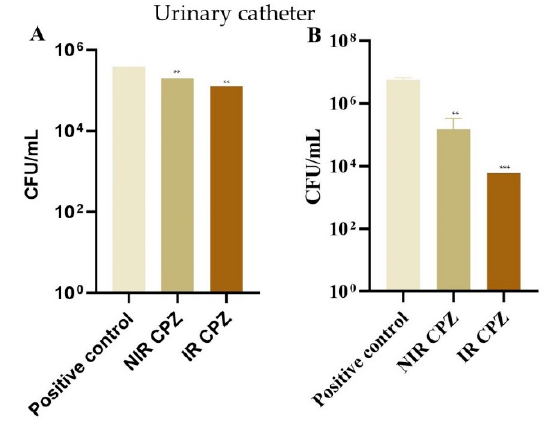
Figure 5. The values of CFU / mL for ( A ). P. aeruginosa clinic, ( B ). MRSA, attached on silicone urinary catheter, all catheter pieces were treated before with non-irradiated and irradiated CPZ solutions. Legend: NIR-CPZ = non-irradiated CPZ and IR-CPZ = irradiated CPZ (data expressed as Mean ± SEM, data points analysed by t-test, levels of statistical significance between the analysed groups: ** p ≤ 0.05, *** p ≤ 0.001). The positive control is represented by bacterial cultures alone.